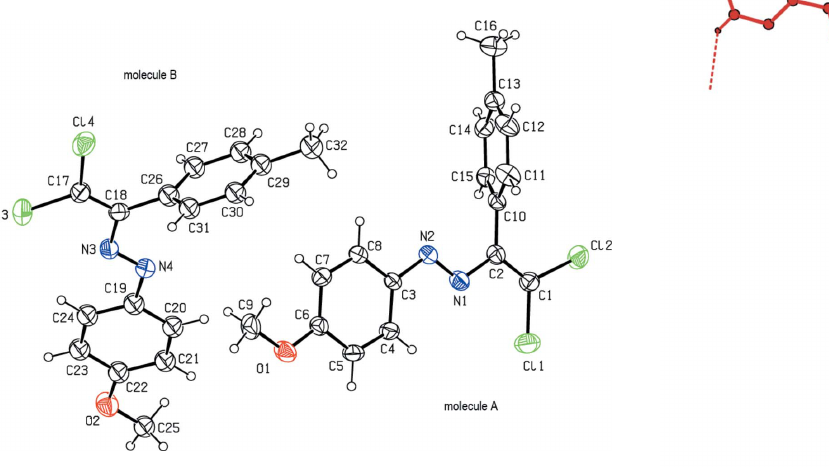
Figure 1 Molecules A and B in the asymmetric unit with the atom-labeling scheme and ellipsoids drawn at the 30% probability level.